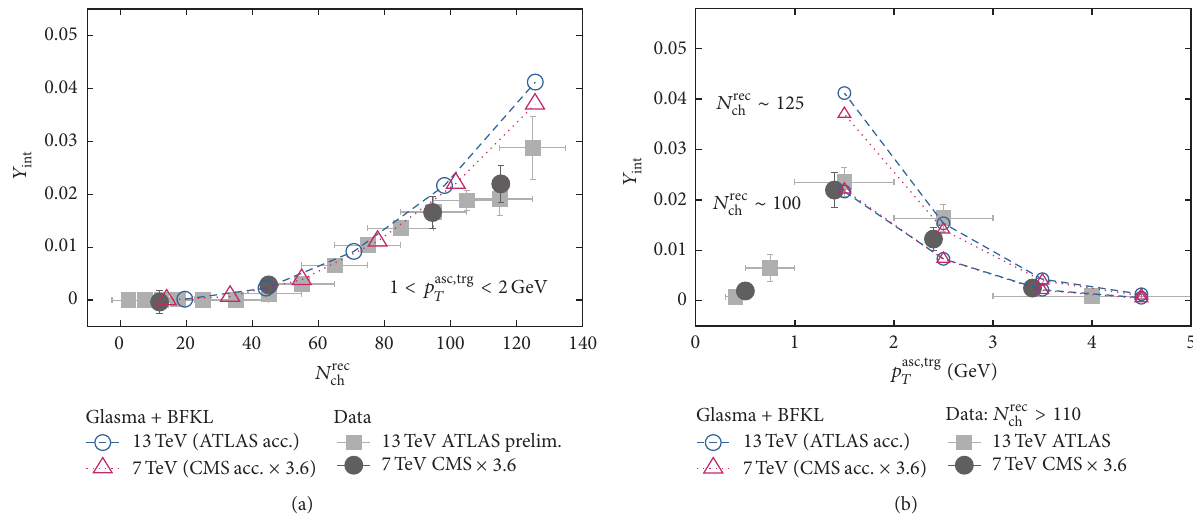
Figure 7: (a) The energy independence of the near-side ridge yield in p+p collisions obtained from [40]; (b) transverse momentum dependence of the same quantity shown for two energies. The model calculations are compared to data from the CMS and the ATLAS